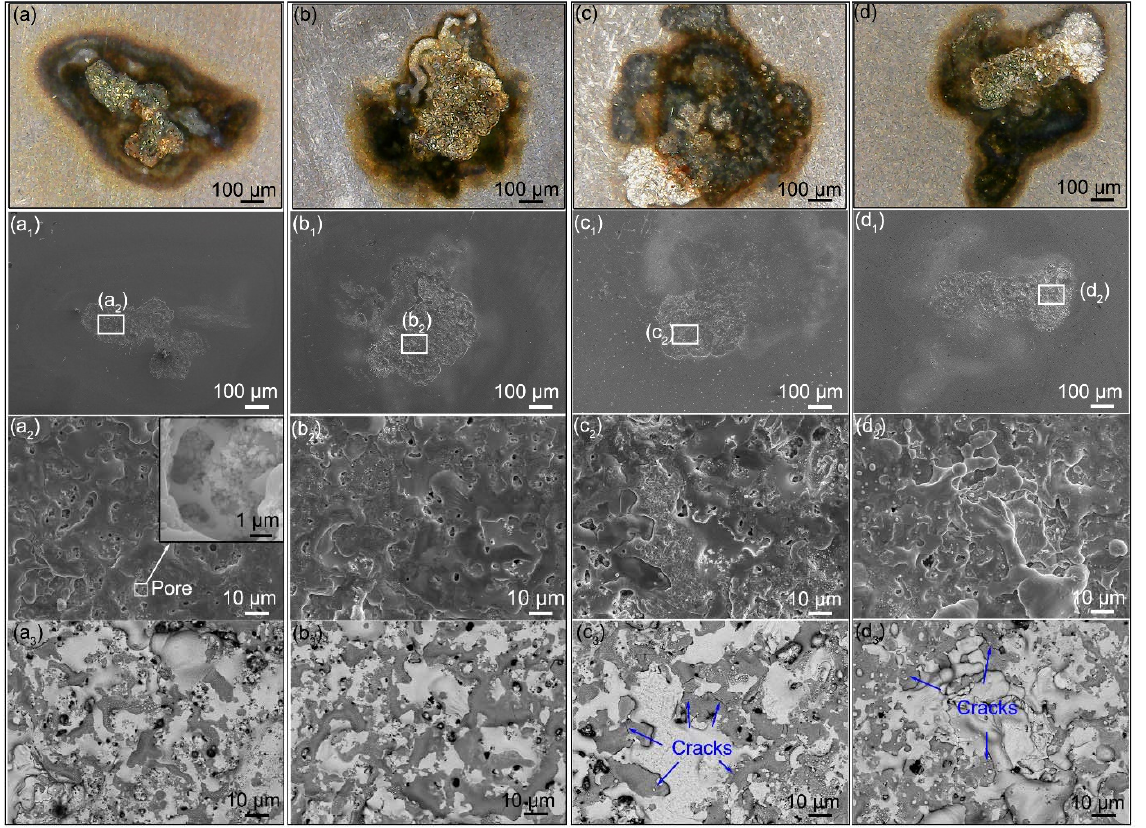
Figure 8. Microstructure changes of the Ag/Y 2 O 3 anodes after one ‐ time arcing erosion: ( a – d ) optical images, ( a 1 – d 1 ) low ‐ magnification SEM images, ( a 2 – d 2 ) high ‐ magnification SEM images, and ( a 3 – d 3 ) backscattered electron (BSE) images. The mean size of Y 2 O 3 used: ( a – a 3 ) 243 nm, ( b – b 3 ) 387 nm, ( c – c 3 ) 792 nm, ( d – d 3 ) 980 nm.